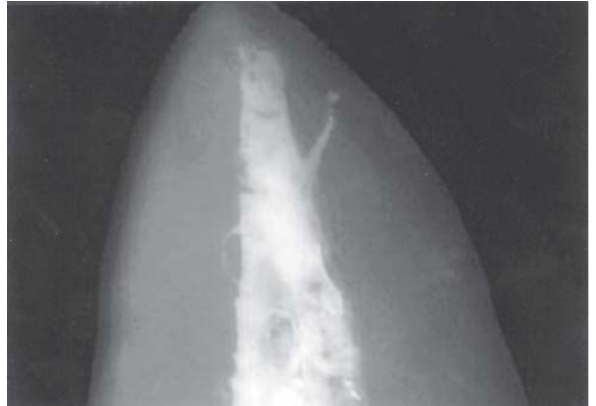
FIGURE 3- Example of score 3